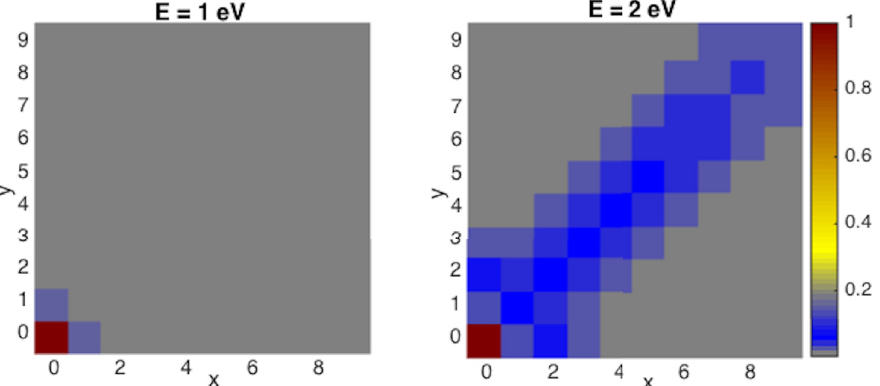
Fig. 3. Weight of the scattered wave function ( | Ψ p ( E ) (cid:3) ) on different sites ( x,y ) of the square lattice normalized to its value on the initial site ( |(cid:4) x,y | Ψ P ( E ) (cid:3)| 2 / |(cid:4) 0 , 0 | Ψ P ( E ) (cid:3)| 2 ) for various absorbed photon energies ( E ). The energy continuum ( EC ) is between 0.8 and 3.2